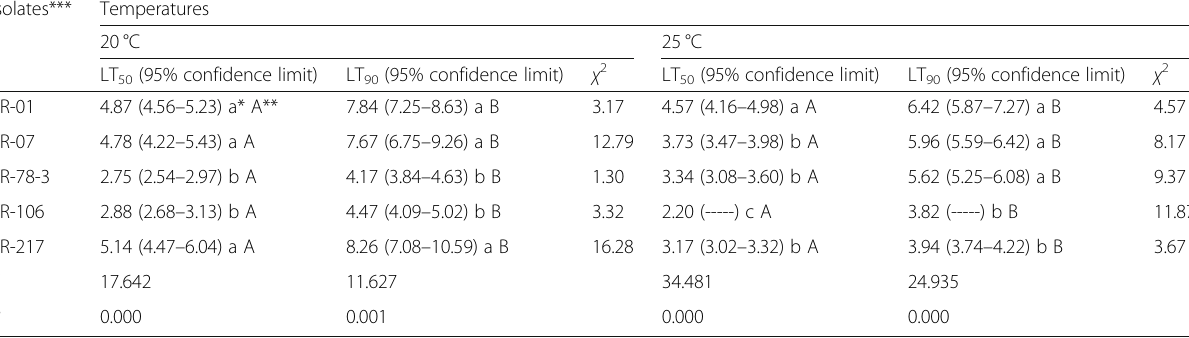
Table 1 Lethal time (LT 50 and LT 90 ) for Sitophilus oryzae treated with the tested entomopathogenic fungal isolates at 20 and 25 °C